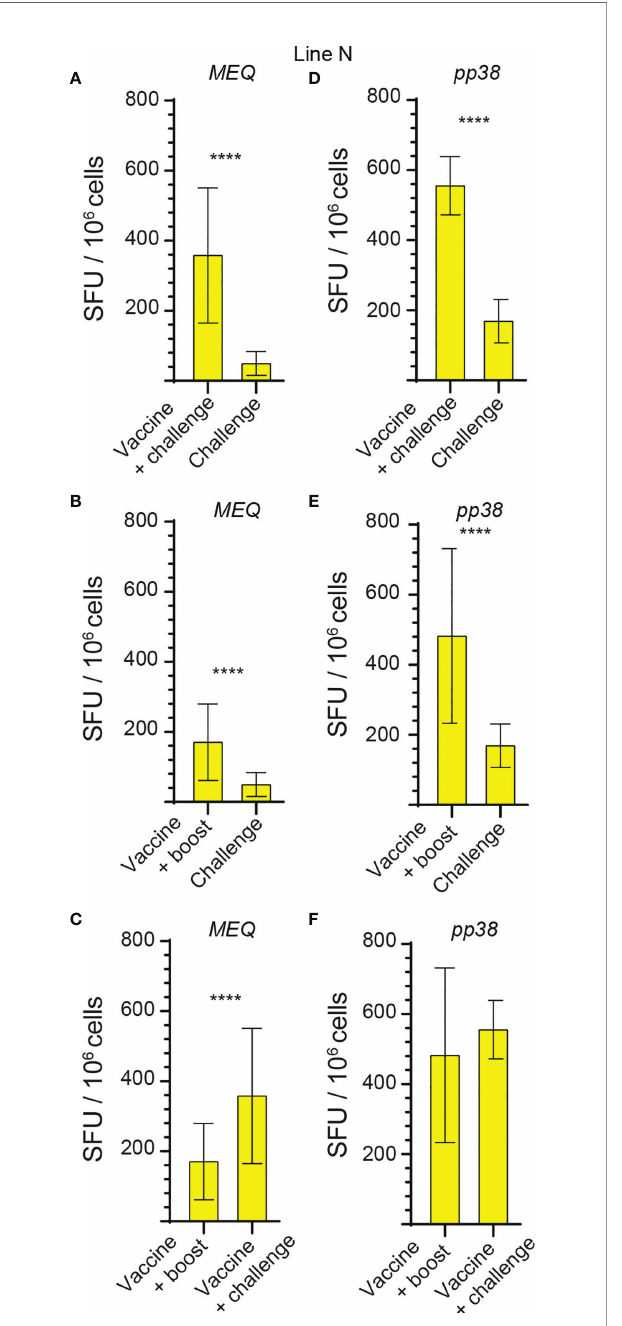
FIGURE 6 | No MEQ -speci fi c IFN-gamma producing T cell response is induced in vaccine-boost group in line P2a chickens at 2 weeks post last inoculation. The frequencies of antigen-speci fi c IFN-gamma producing T cells, detected using a standard ex vivo ELISPOT assay, to (A – C) MEQ and (D – F) pp38 derived peptide pools in the different experimental groups of line P2a chickens at 2 weeks post last inoculation are shown. The results are presented as SFU per 10 6 cells and shown as mean ± SD. Non-parametric Wilcoxon tests (Mann – Whitney) was used to assess normal distribution and test signi fi cance. * ( P ≤ 0.05), ** ( P ≤ 0.01), *** ( P ≤ 0.005) and **** ( P ≤ 0.001) indicates as statistically signi fi